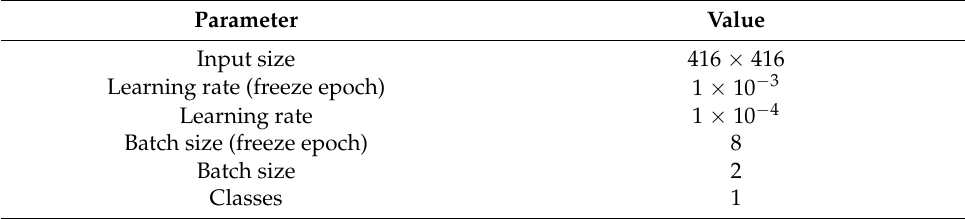
Table 3. Parameter